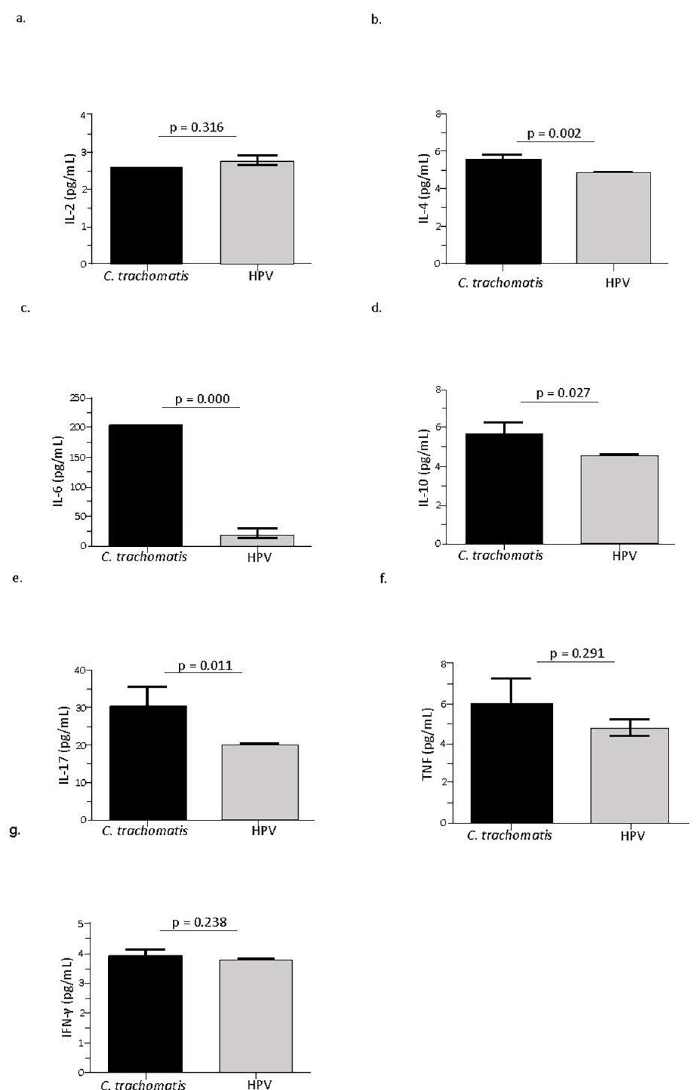
Fig 2. Cytokine levels (pg/ml) in exfoliated cervical cells (ECC) from Chlamydia trachomatis ( C . trachomatis ) DNA-positive samples and human papillomavirus (HPV) DNA-positive samples.